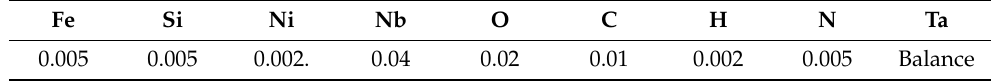
Table 1. Ta chemical composition table (wt.).